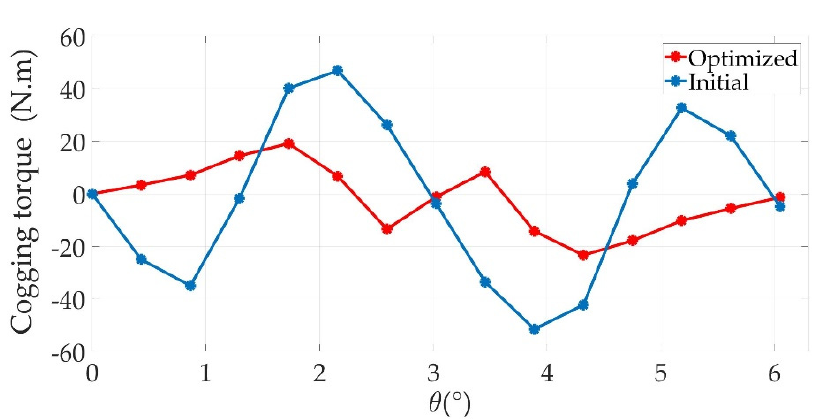
Figure 25. Comparison of cogging torque of two machines.